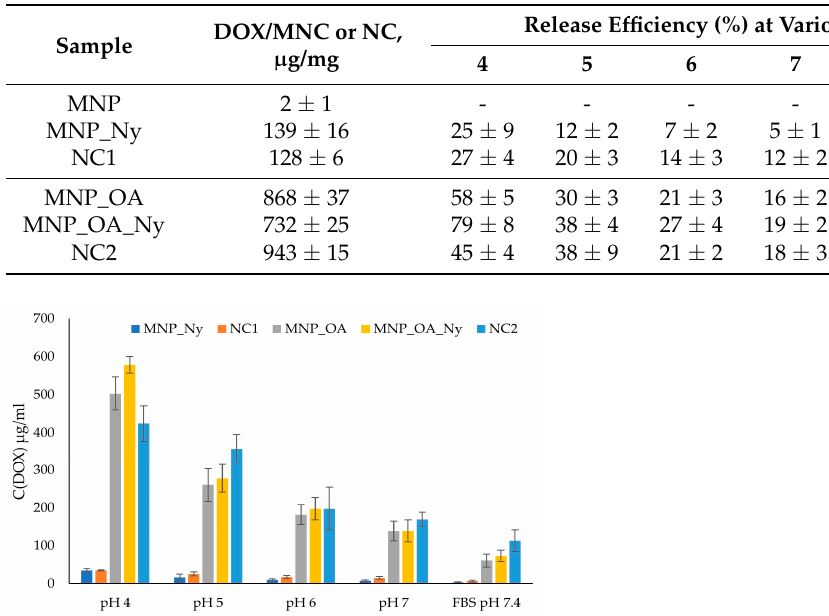
Table 4. DOX release efficacy after 3 h incubation in percentages.